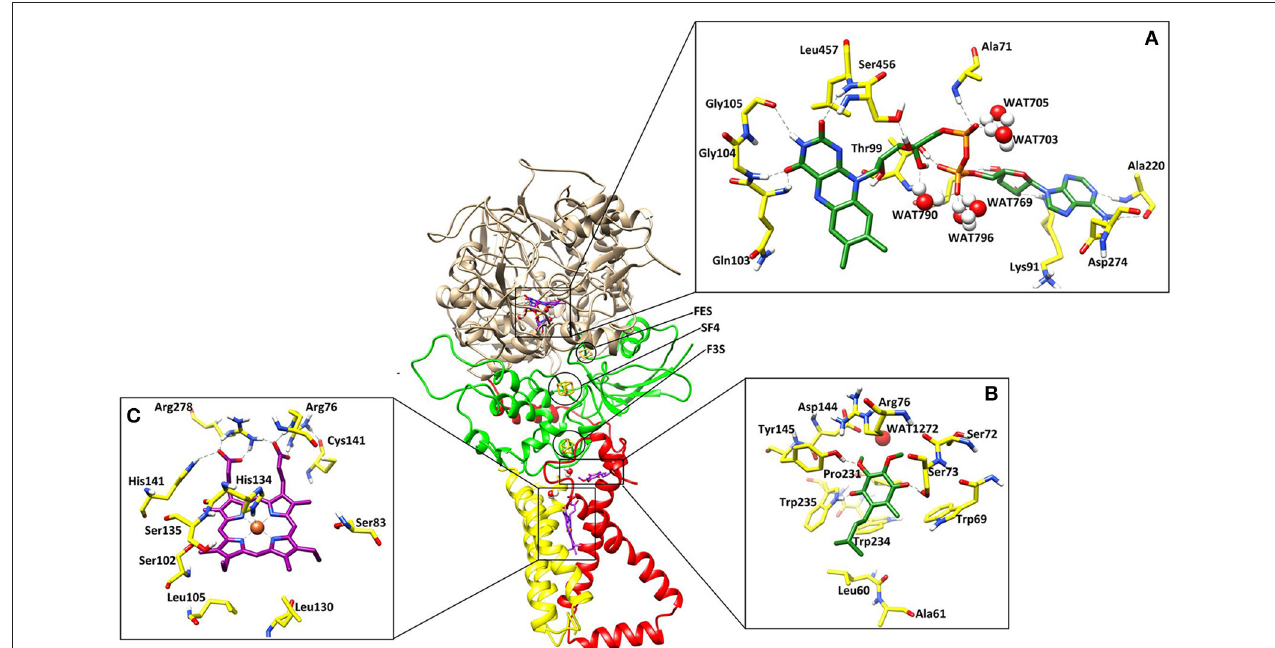
FIGURE 1 | The three dimensional structure of the A. solani SDH model. SDHA (Fp), SDHB (Ip), SDHC (CybL) SDHD (CybS) are depicted in tan color, green, red, and yellow colors, respectively. (A) Binding interactions of FAD. The ligand and the surrounding residues are depicted in Green and Yellow sticks, respectively (B) Binding interactions of Ubiquinone. The interacting residues are shown in Green and Yellow sticks, respectively (C) Binding interactions of Heme. The interacting residues are shown in Purple and Yellow sticks, respectively. The Hydrogen bonding are displayed in Green dotted lines.